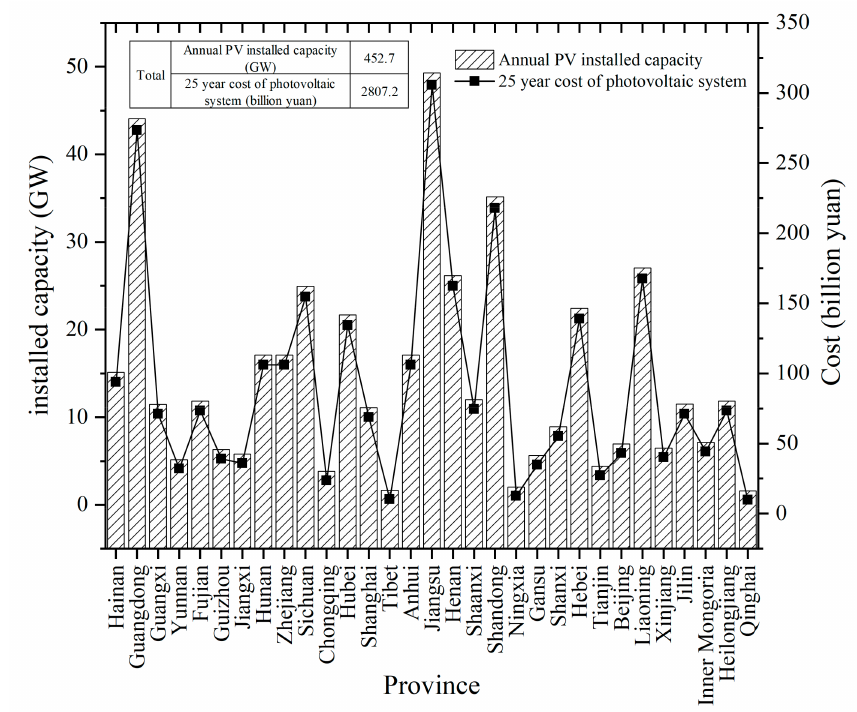
Figure 11. 25-year cost of photovoltaic system construction in various